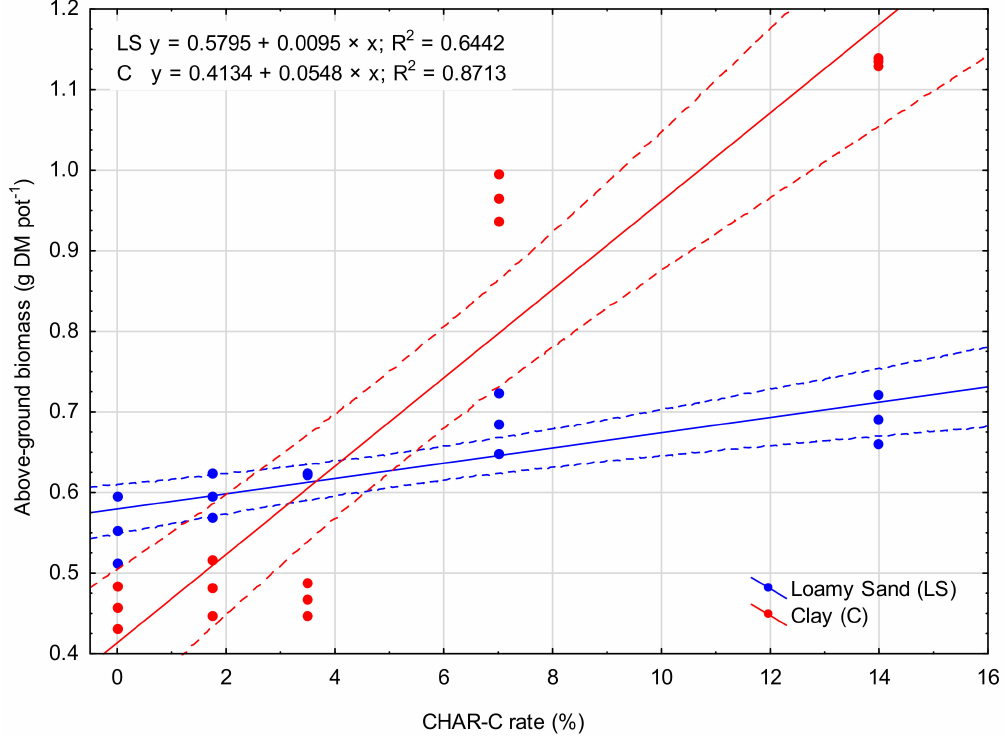
Figure 7. Relationship between the CHAR-C rate and aboveground biomass productivity of S. saccharatum (L.). The solid line is the fitted linear regression, and the dotted lines represent the 0.95 confidence